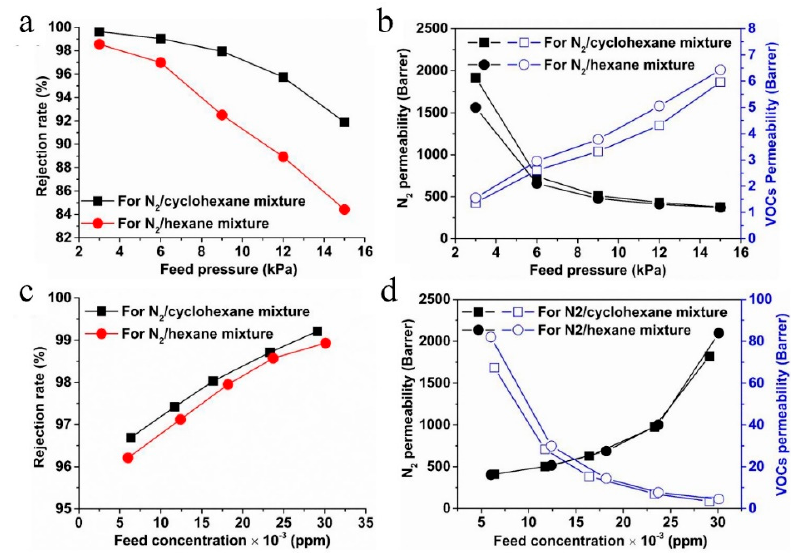
Figure 20. Effects of feed pressure ( a , b ), separation was conducted in a crossflow mode at 25 °C and about 30000 ± 1250 ppm feed VOC concentration, and feed concentration ( c , d ), separation was conducted in a crossflow mode at 25 °C under 4 kPa, on membrane separation performance. Reproduced from Reference [71].